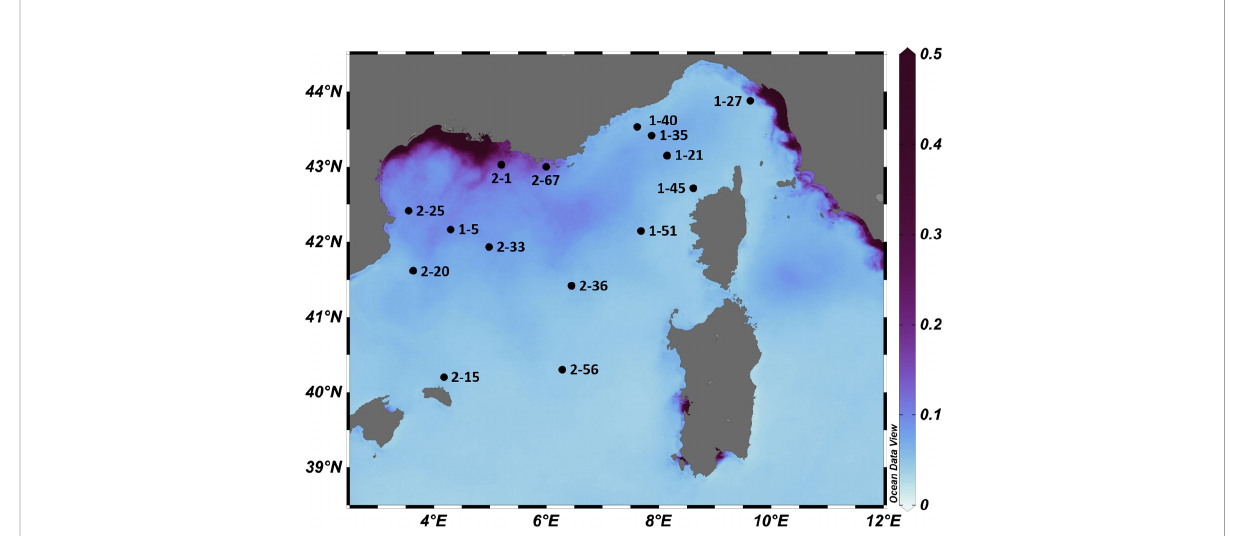
FIGURE 1 Map of the study area (North-Western Mediterranean basin) of the MOOSE-GE expedition with positions of the sampling stations (LEG-Station) that were analysed in this study. Axis colour represents average chlorophyll values in mg m -3 during September 2017, the study period. Data was collected using E.U. Copernicus Marine Service Information